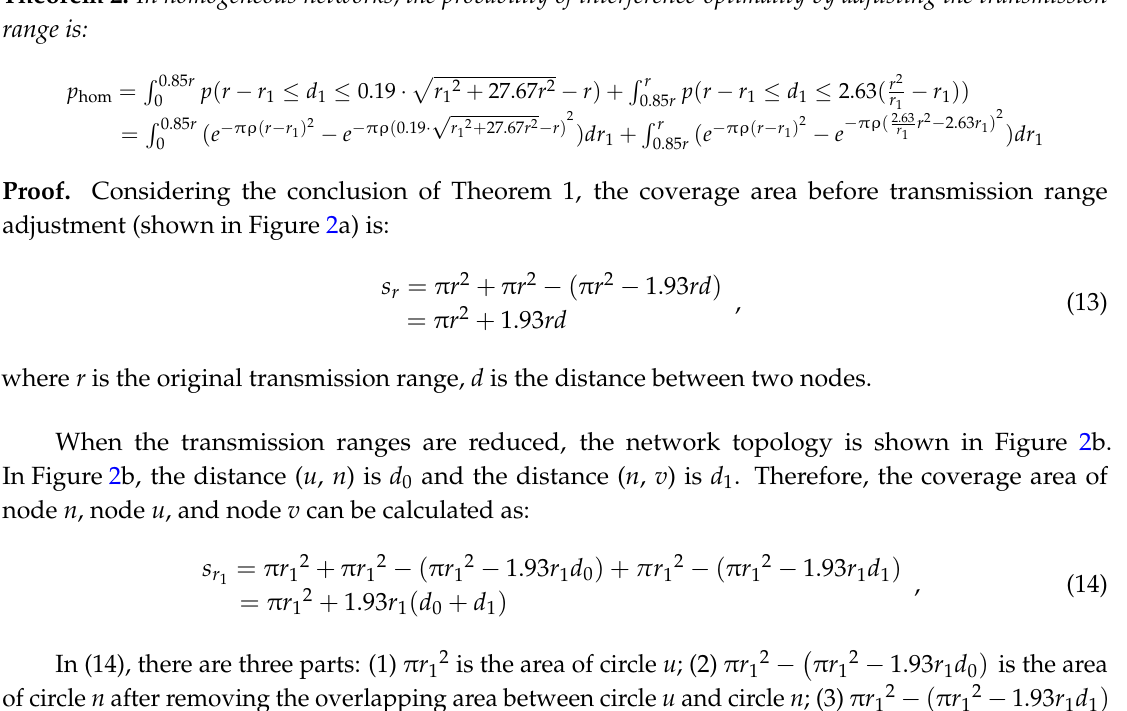
Figure 8. The fitting results of Equations (5) and (11).